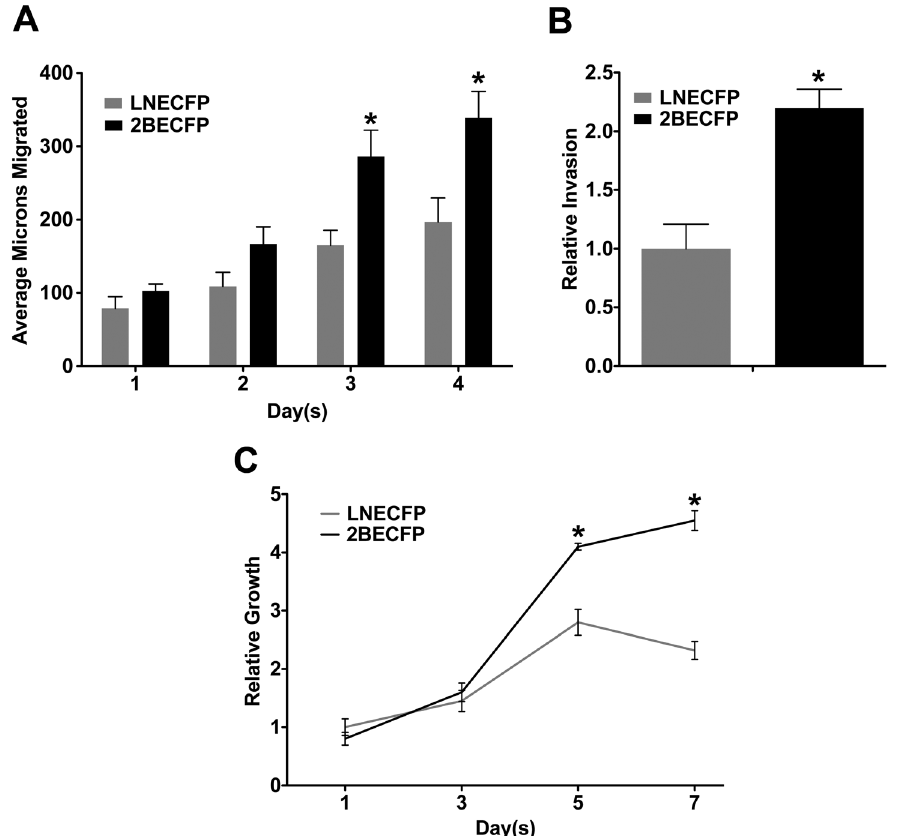
Figure 4. Overexpression of beta-2 enhances LNCaP cell migration, invasion, and growth on laminin. A . Quantified results of wound healing migration assays performed on 60 mm dishes pre-coated with 0.5 m g/mL laminin. 2BECFP cells exhibit a trend in increased migration on laminin compared to LNECFP cells beginning at day 1, with statistical significance achieved at days 3 and 4 (P , 0.05, n=5). B . LNCaP cells engineered to overexpress beta-2 have a 2.2 fold increase in invasion through 50 m g/ml laminin compared to vector control LNCaPs (P , 0.05, n=3). C . Quantified results of MTT assays on 0.5 m g/mL laminin. 2BECFP cells have a statistically significant growth advantage on laminin relative to LNECFP cells beginning at day 5 (P , 0.05, n=5).